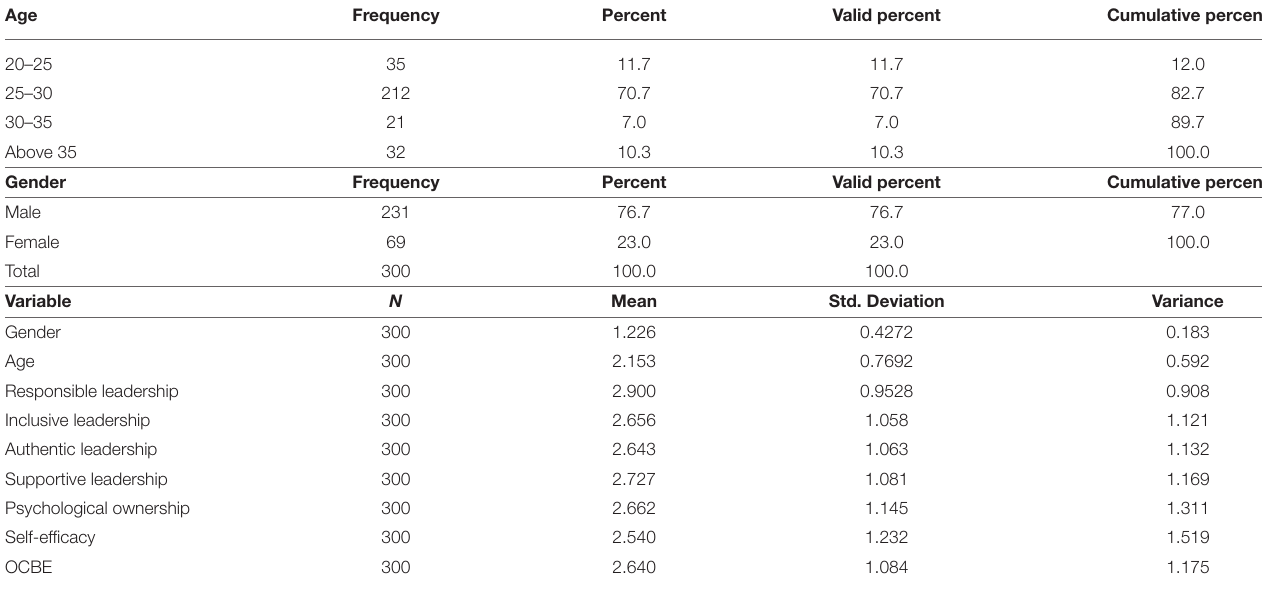
TABLE 1 | Descriptive statistics, means, standard deviations, and variance.